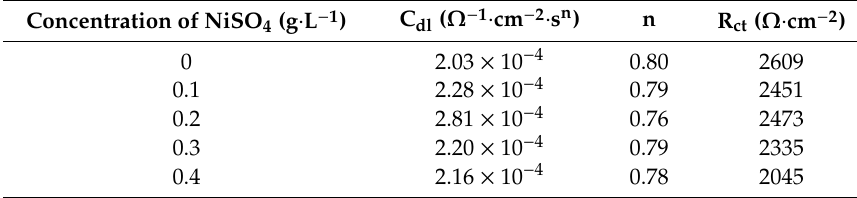
Figure 7. The equivalent circuit used for EIS data fitting. Table 3. Electrochemical parameters of EIS data for different colored specimens.